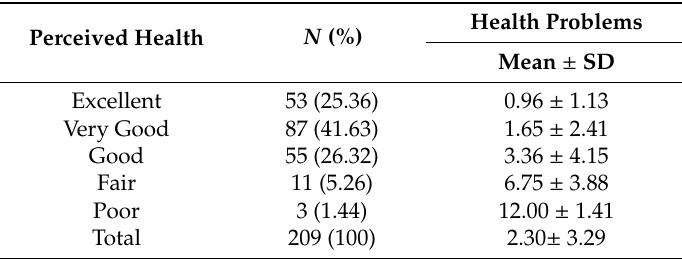
Table 2. Number of health problems reported for each level of perceived health among long-term survivors of childhood cancer survivors. Perceived Health N (%)